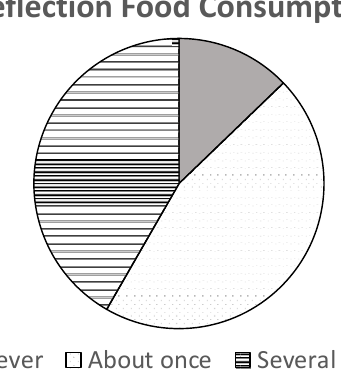
Figure 2. Frequency distribution of reflective consumption. N = 1435.